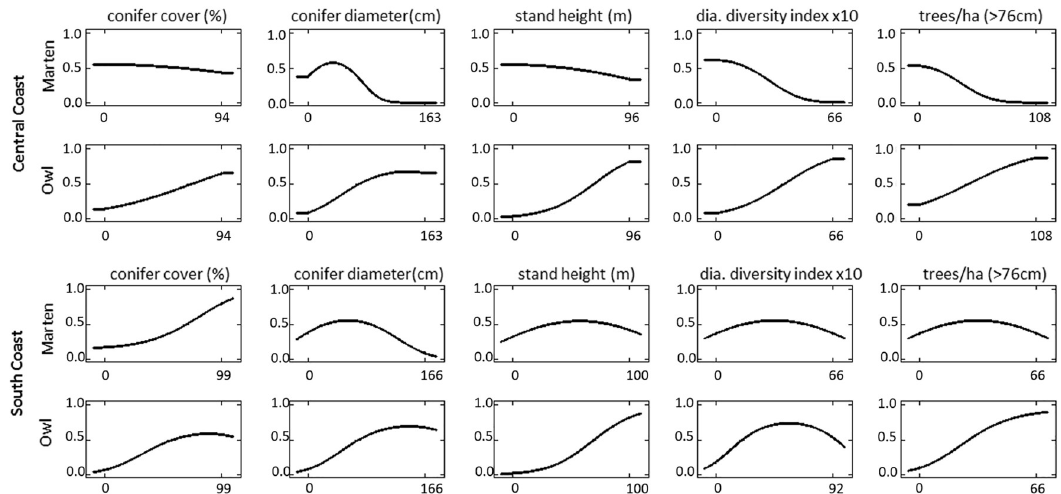
Fig 6. Humboldt marten and spotted owl distribution predictor response. Individual predictor variables response functions for each species within two modeling regions (south and Central Coast). Predictor variables for northern spotted owls ( Strix occidentalis caurina , Owl) and a coastal subspecies of Pacific marten ( Martes caurina humboldtensis , Marten) were generated from remotely sensed data [7] and included percent canopy cover, diameter at breast height, average tree height (stand height), diameter Diversity Index (dia. Diversity index) and trees per hectare (ha). Additional descriptions of variables are found in Table 1.